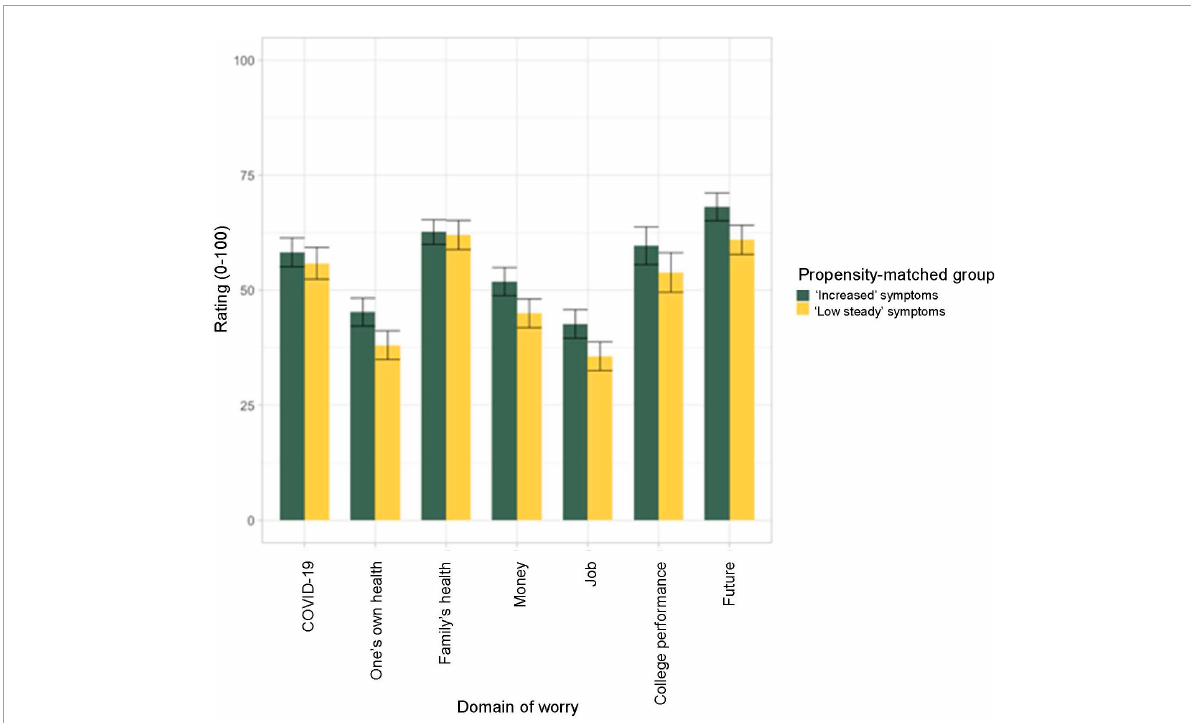
FIGURE3 Average level of worry endorsed for different domains of concern related to the COVID-19 pandemic. Ratings were averaged across Spring, Summer, and Fall 2020 time points. Student on average reported worrying the most about their family’s health and their future. There were no significant differences between the propensity matched groups exhibiting “increased” depression symptoms or “low stable” depression symptoms from before to after the start of the COVID-19